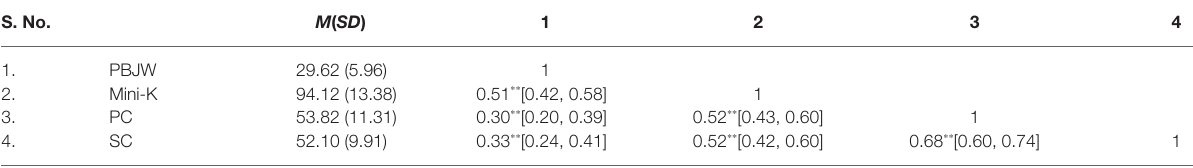
TABLE 1 | Descriptive statistics, correlations [95% confidence intervals] between variables ( n = 408). S. No.